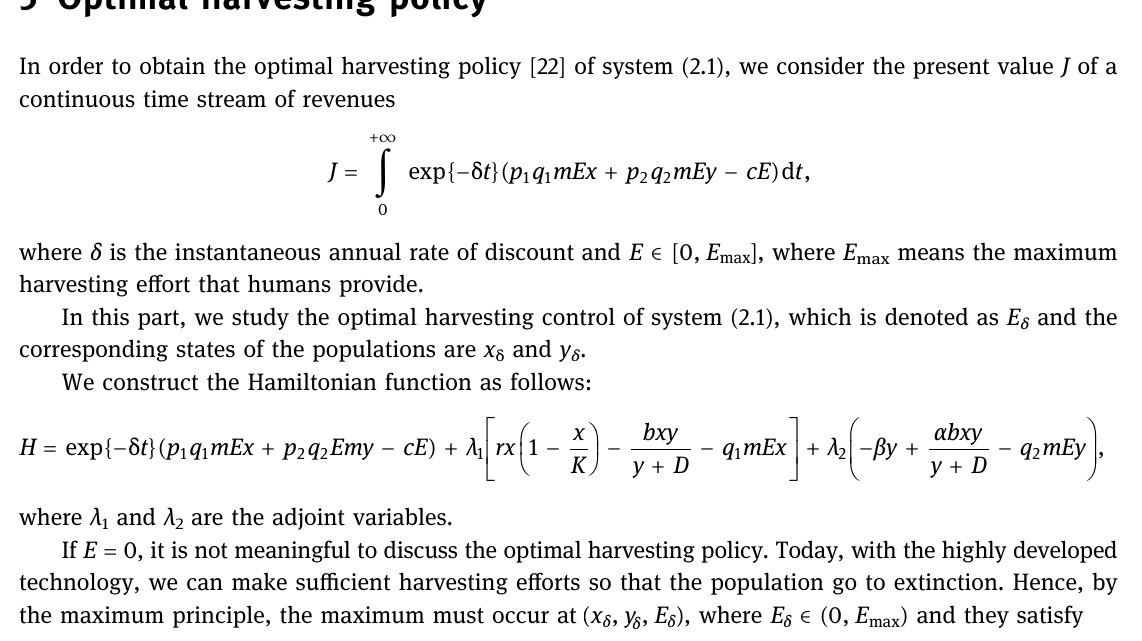
Table 3: The price of predator fi sh p 2 changes from 10 to 16 with = = c p 60, 7 p 2